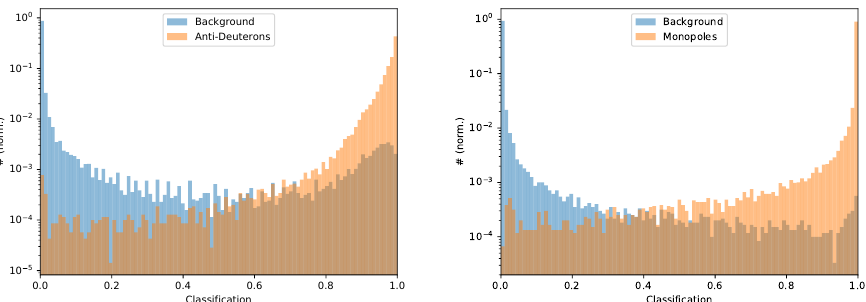
Figure 4: Classification distribution according to Feed-Forward Network trained with cluster properties of magnetic monopoles and background (right-hand side) as well as anti-deuterons and background (left-hand side). Low classification values correspond to background, high values to signal. The true background is colored in blue, the true signal in